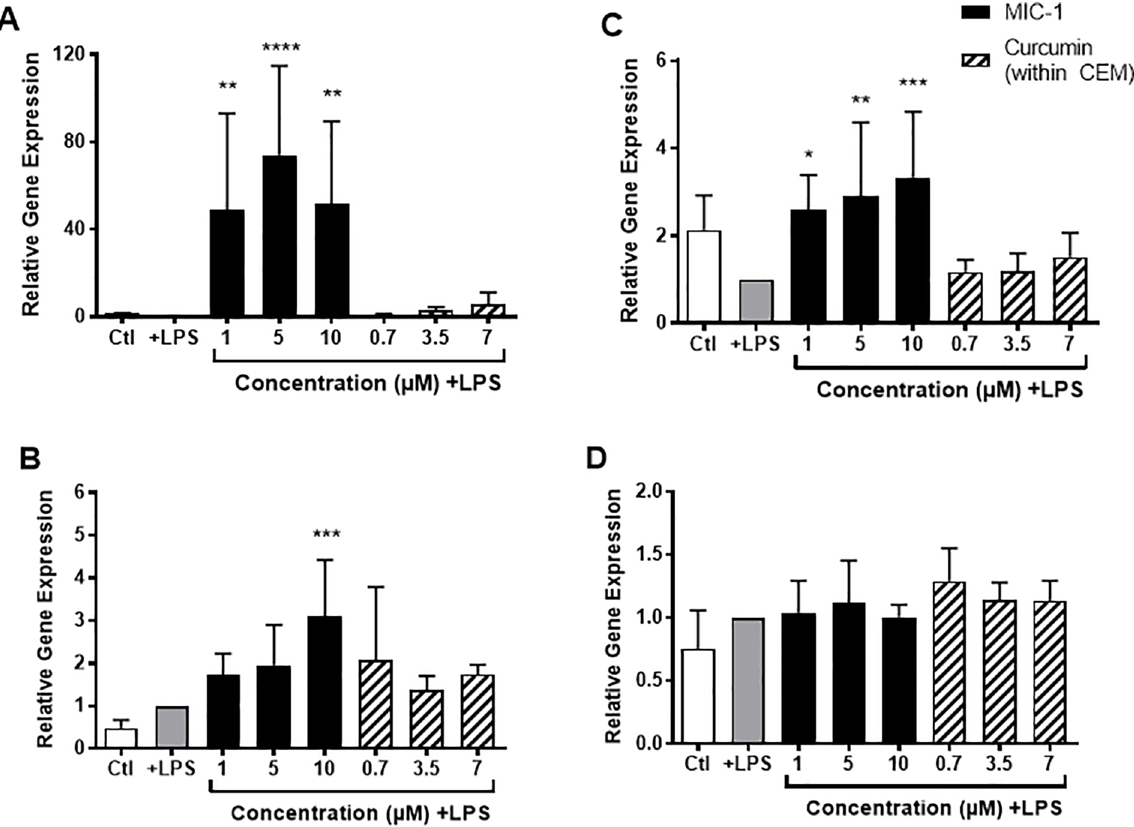
Fig 8. Effect of MIC-1 (1, 5, and 10 μ M) and CEM (curcumin concentration of 0.7, 3.5 or 7 μ M) on Nrf2-mediated detoxification gene expression in LPS-stimulated RAW 264.7 murine macrophages. Gene expressionof A) NQO1, B) HO1, C) GSTP1, and D) NRF2 comparedto Ctl without LPS and +LPS control. Data are the mean ± SD of 7 independent experiments. * P < 0.05, ** P < 0.01, *** P < 0.001, **** P < 0.0001, one-wayANOVA followedby Dunnett’s post hoc test comparedto +LPS